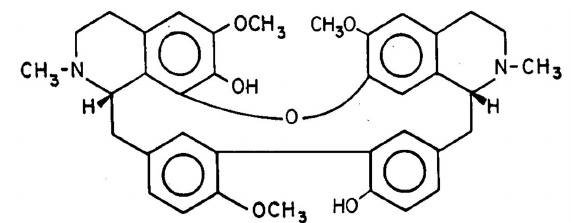
Figure 1 - Tetrandrine, isolated from Stephania tetrandra S